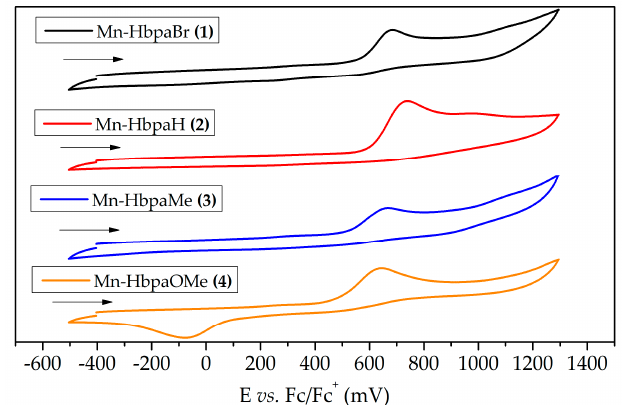
Figure 5. Cyclic voltammograms of compounds ( 1 )–( 4 ) in dichloromethane under argon atmosphere. Experimental conditions: 0.1 mol L − 1 TBAPF 6 as the supporting electrolyte, Ag/AgCl as the reference electrode, and platinum as the work and auxiliary electrodes. Potentials are referenced to the Fc/Fc + couple (E 1/2 = 0.405 V vs. Ag/AgCl in dichloromethane).